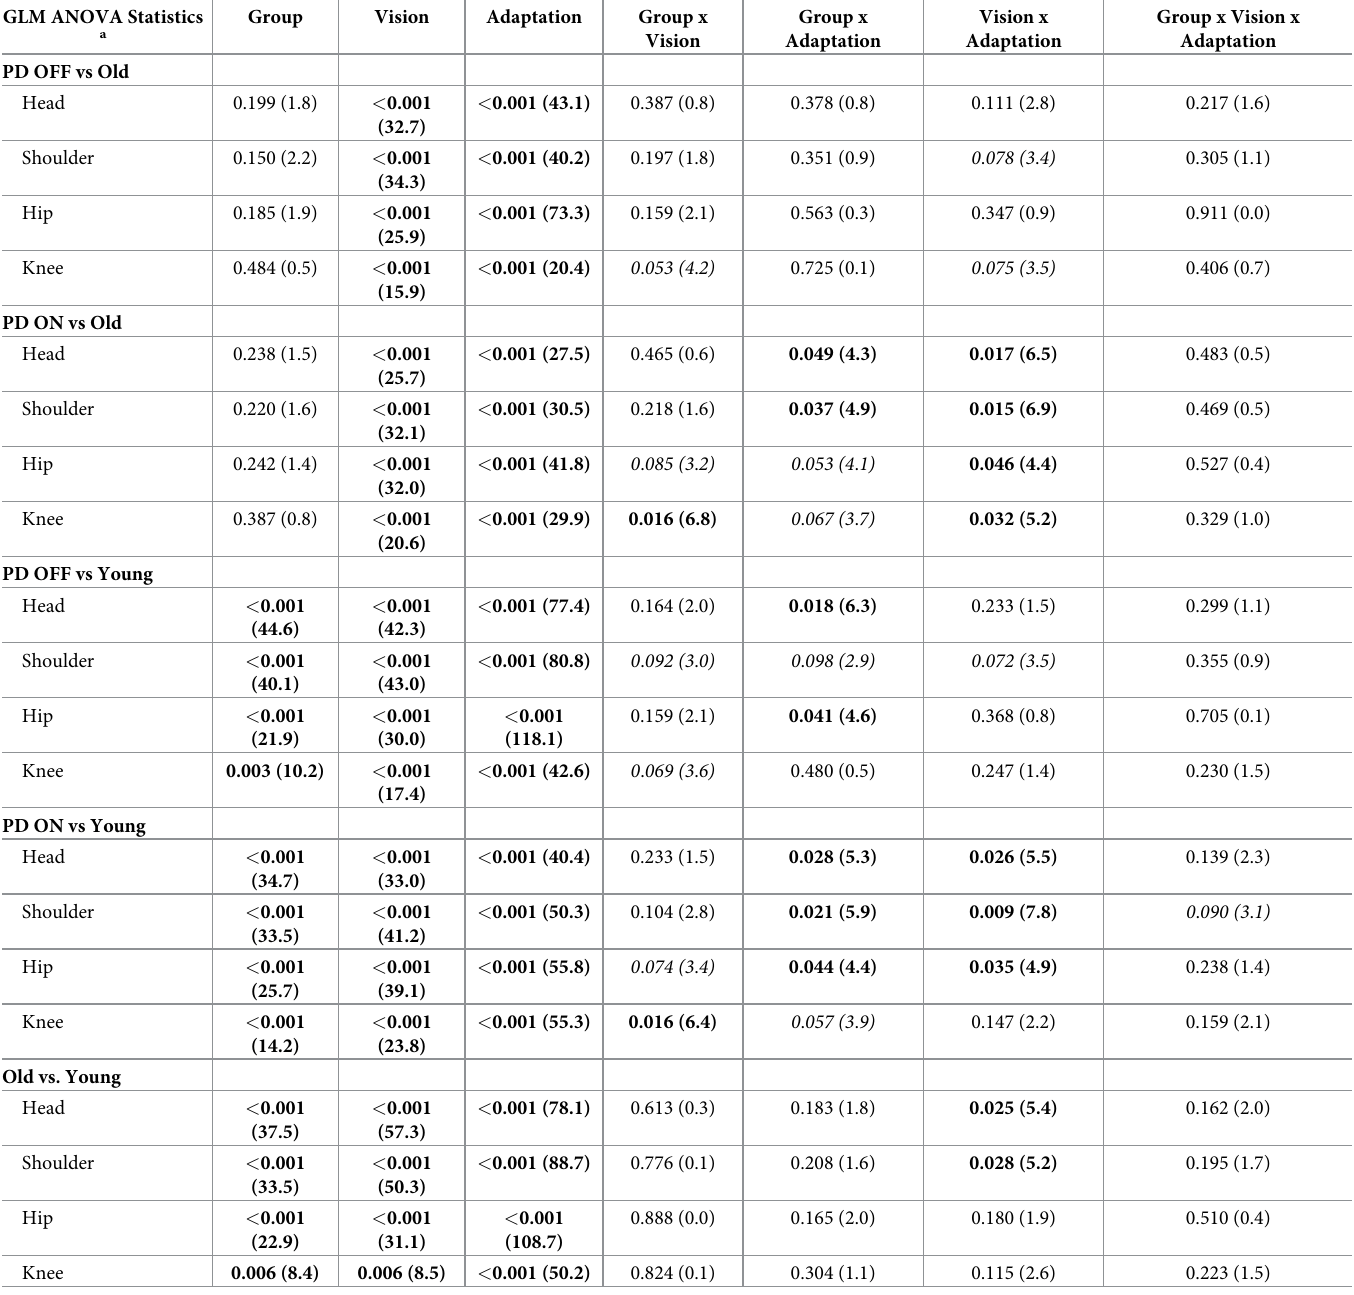
Table 6. Group, vision and adaptation effect on the size of the body